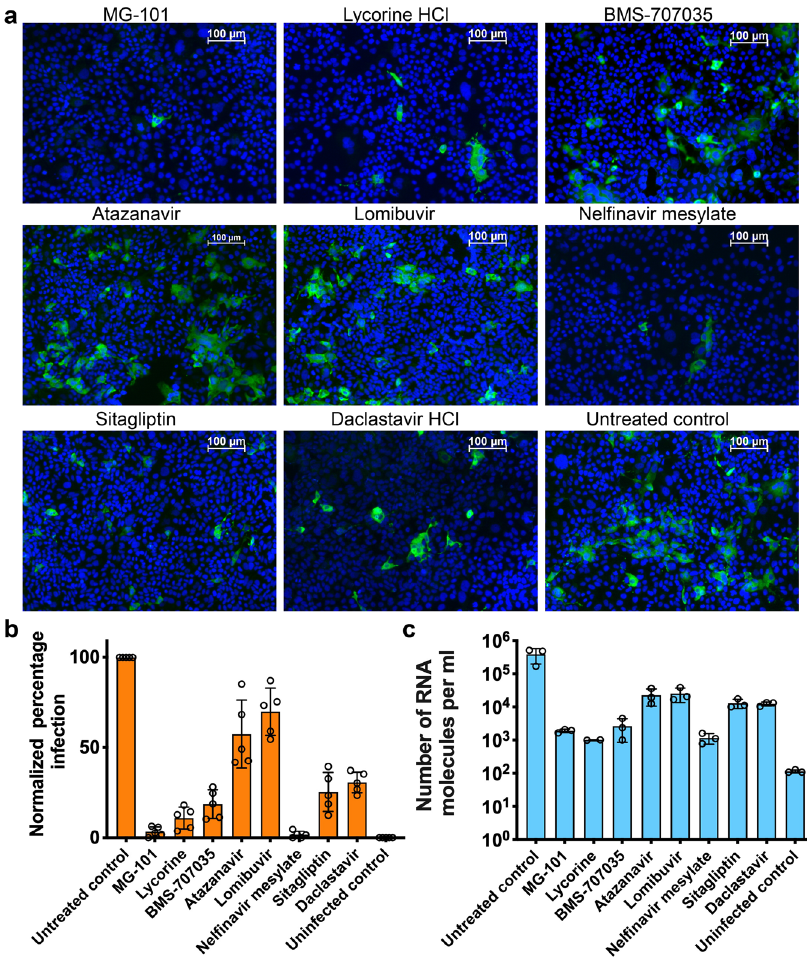
Fig. 5 Effect of compounds selected from ICP assay on SARS-CoV-2 replication. a Huh-7.5 cells positive for SARS-CoV-2 determined by immuno fl uorescence assay. Huh-7.5 cells pre-treated for 24 h with inhibitors were infected with SARS-CoV-2 at an MOI of 0.1. At 24 h.p.i., cells were fi xed with paraformaldehyde and probed with anti-N (SARS CoV-2 nucleocapsid) primary antibody and FITC-conjugated goat anti-rabbit secondary antibody (green, infected cells). Nuclei were stained with Hoechst stain and confocal images were acquired. b The ratio of infected to uninfected cells for each treatment was calculated using Nikon Elements software and normalized to untreated controls ( n = 5). c Quanti fi cation of SARS-CoV-2 RNA molecules from infected cells treated with inhibitors as indicated ( n =